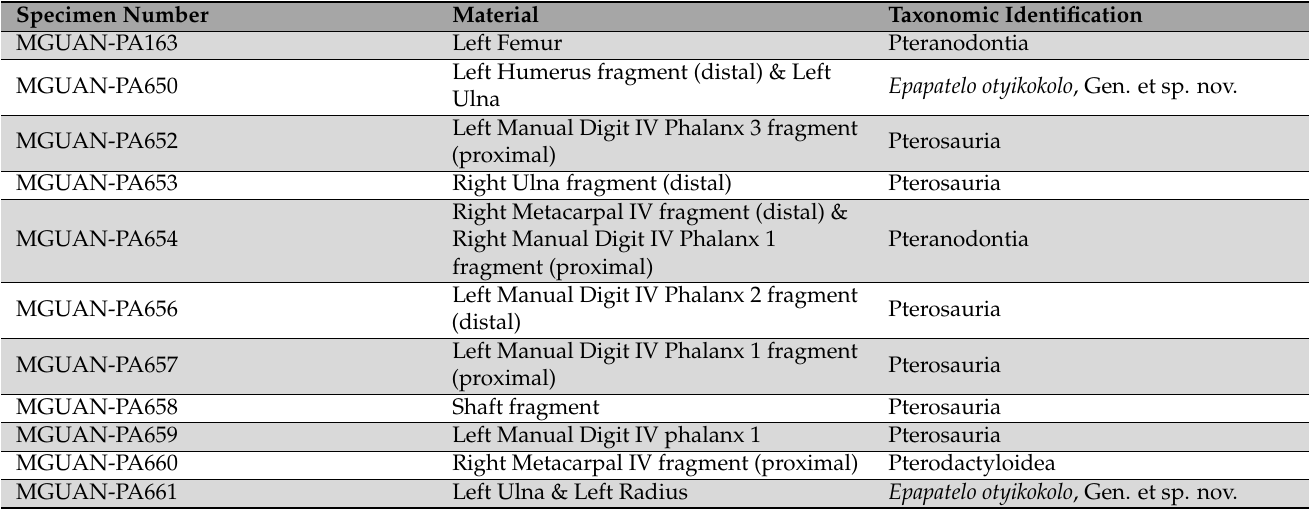
Table 1. Bentiaba pterosaur elements and